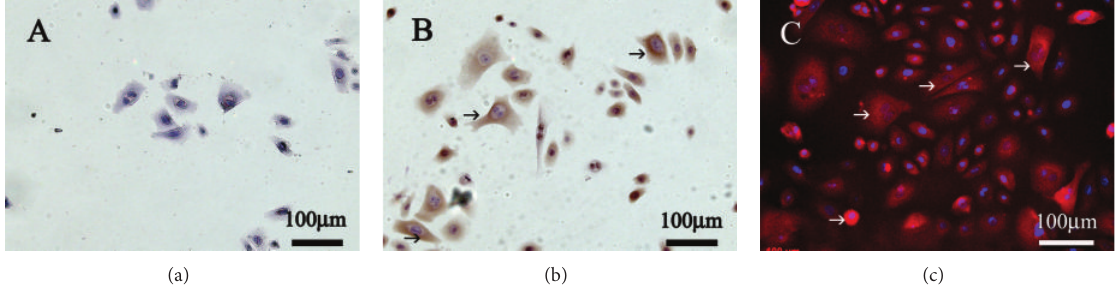
Figure 2: Cytochemical ((a): negative control, (b): anti-glycine receptor) and immunofluorescence ((c) anti-glycine receptor) staining for Glycine receptor in cultured human gingival keratinocytes (red color, black arrow). For nuclear staining, cells were treated with DAPI (blue color, (c)).